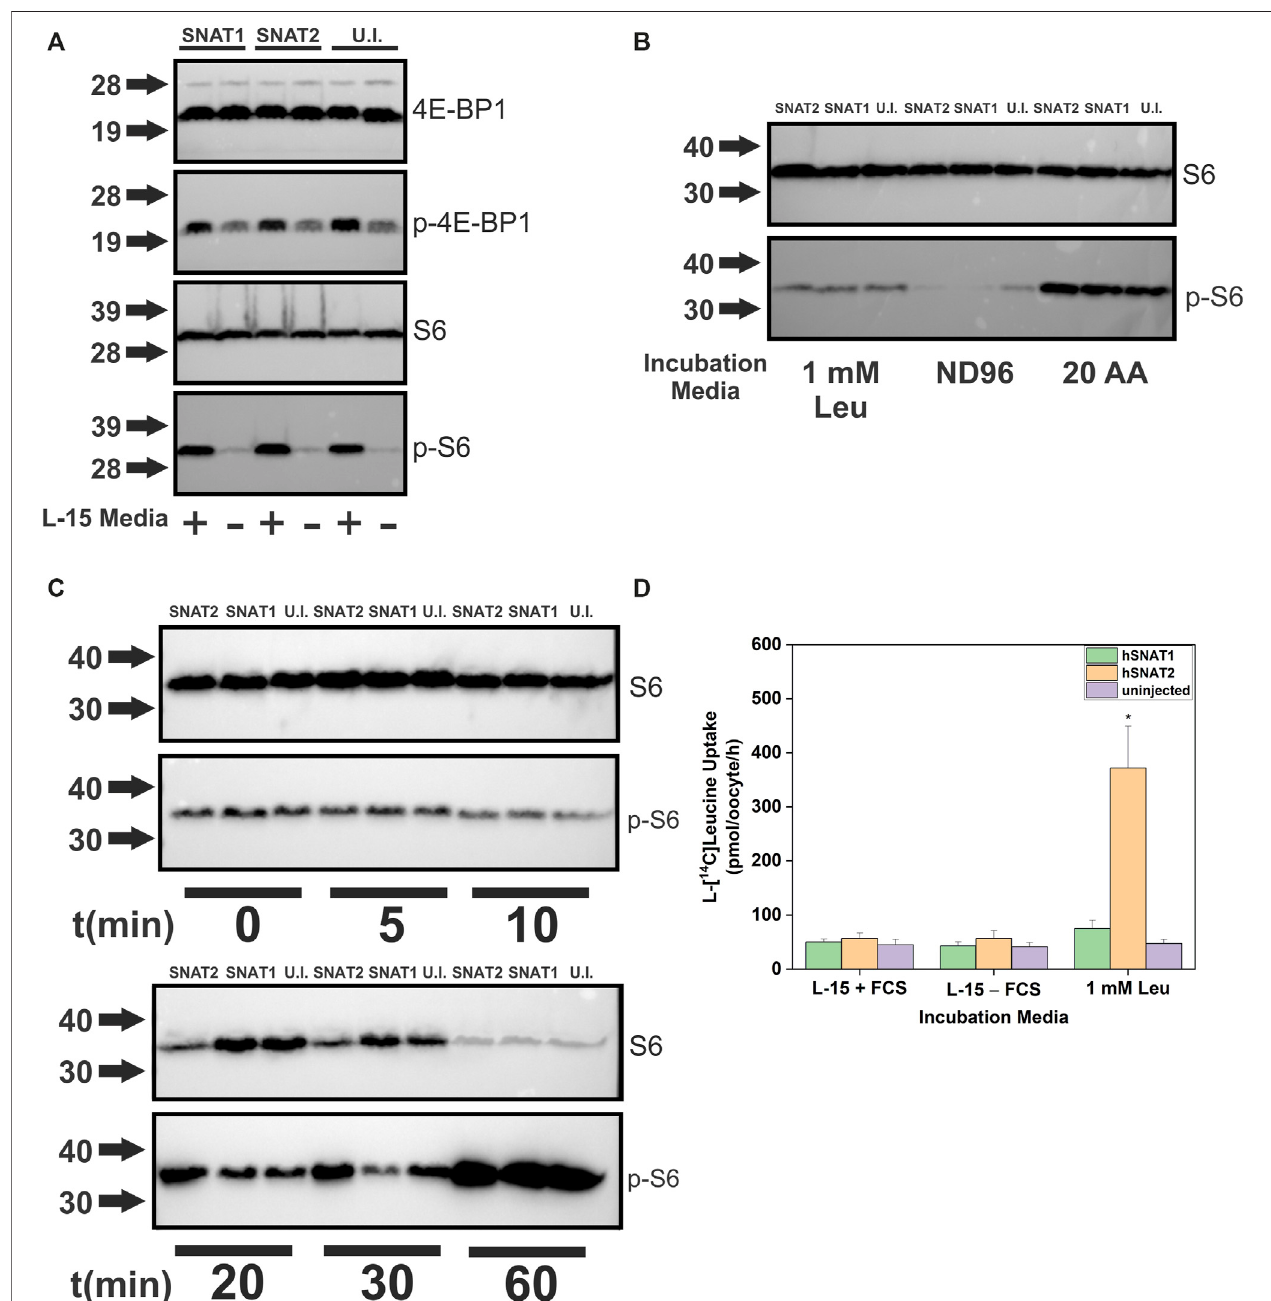
FIGURE8| Human SNAT2 but not SNAT1 isanactivator ofmTORC1. Oocytes wereinjected with10 ng cRNA ofeitherSNAT1or SNAT2.After 4 days incubation in OR2 + (pH 7.8), oocytes were incubated in modi fi ed L-15, 1 × ND96 (pH 7.4) or a mix of all 20 AA in ND96. The activation of mTORC1 targets was ascertained by immunodetection ofS6/phospho-S6 and 4E-BP1/phospho-4E-BP1. (A) Changesof4E-BP1 and S6 phosphorylation in X.laevis oocytes incubated inL-15 biomimetic media or 1 × ND96 (pH 7.4) over 4 h. (B) Changes to the phosphorylation state of ribosomal protein S6 by a mixture of 20 proteinaceous amino acids, or leucine alone after 4 h incubation. Amino acids were added at a concentration of 1 mM each. (C) Time course of S6 phosphorylation after incubation in 20 × AA (1 mM each) mixtureinoocytesexpressingSNAT1,SNAT1orun-injectedoocytes. (D) Uptakeof1 mM L-[ 14 C]leucinewasmeasuredinthepresenceofL-15biomimeticmedia,20 × AAor1 mMleucinealone over4 h. * IndicatesadifferenceinthemeansbetweenoocytesexpressingSNAT2 andthoseexpressingSNAT1 orun-injectedoocytesinthe same incubation media ( p < 0.05, n (cid:2) 10 oocytes, 3 experimental repeats).